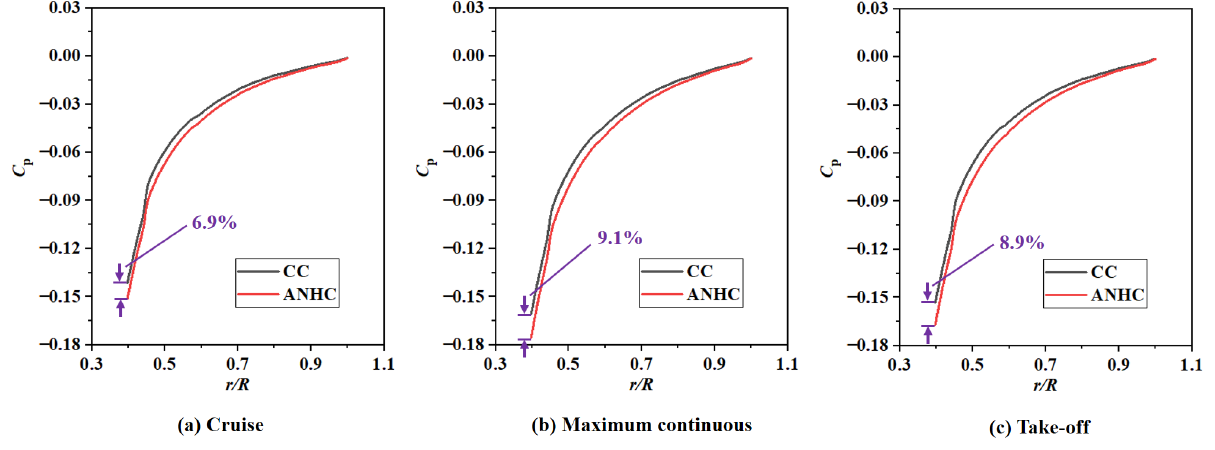
Figure 13. Pressure coefficient distributions of rotating disk surface under CC and ANHC.